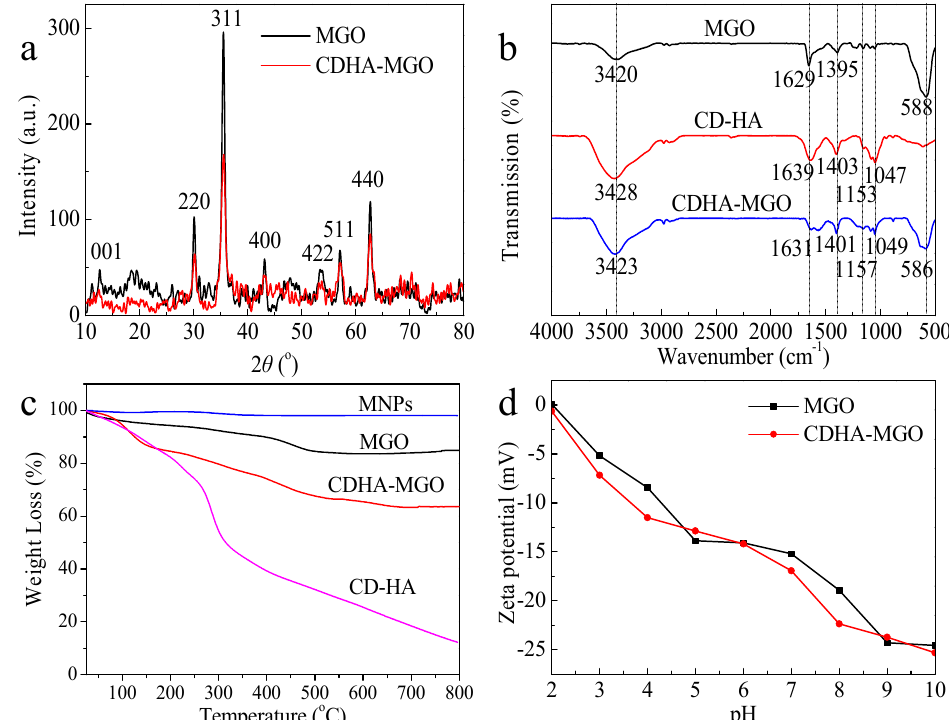
Figure 2. ( a ) XRD patterns of the MGO and CDHA–MGO; ( b ) FTIR spectra of MGO, CDHA and CDHA–MGO; ( c ) TGA curves of magnetic nanoparticles (MNPs), MGO, CDHA, and CDHA–MGO; ( d ) Zeta potentials of MGO and CDHA–MGO at different pH values.